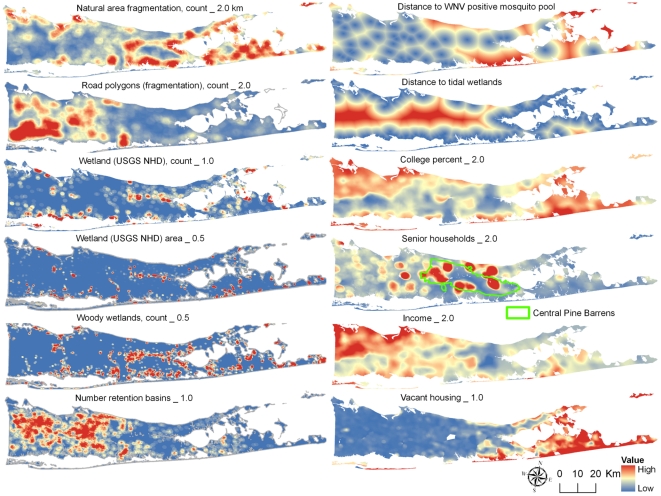
Geographic distribution of West Nile Virus (WNV) human risk predictors with the corresponding spatial scales in the final logistic regression model.Census variables were acquired at the smallest geographic unit available, i.e. census block to a block group, to census tract. The original independent variable shapefiles were converted to rasters in ArcMap GRID 30×30 meter format. The resulting grid layers were processed using Neighborhood function in ArcMap Spatial Analyst extension to produce smoothed output layers in which the value of each grid cell was a function of the cells within specified neighborhoods, i.e. the corresponding spatial scales of 0.5, 1.0, or 2.0 km (indicated by a number after each independent variable on the map). Similarly, each cell in distance grid layers (indicated as Distance to on the map) was assigned a value representing Euclidean distance to the nearest source cell.